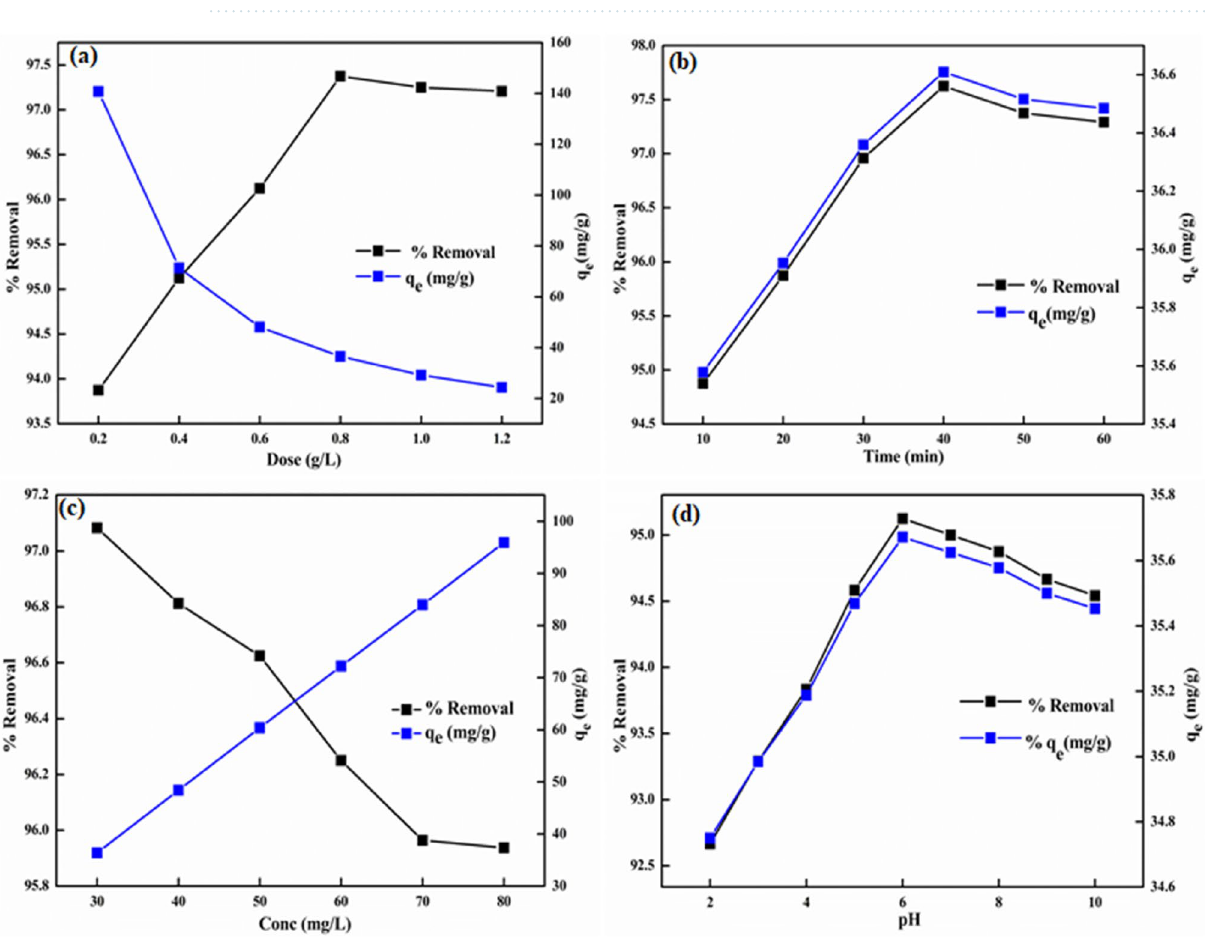
Figure 5. Effect of operational parameters on the removal of NB: ( a ) dose, ( b ) contact time, ( c ) initial concentration, and ( d ) initial solution